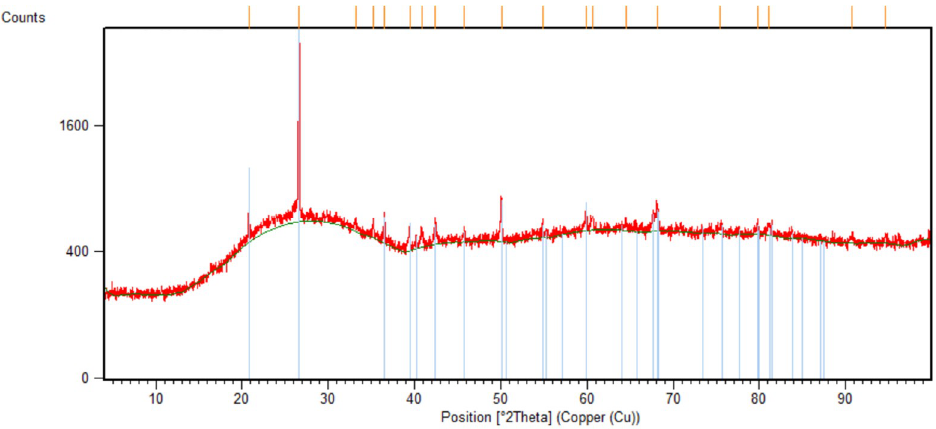
Figure 3. X-ray di ff raction (XRD) results of the CSP used in this Figure 3. X-ray diffraction (XRD) results of the CSP used in this study.